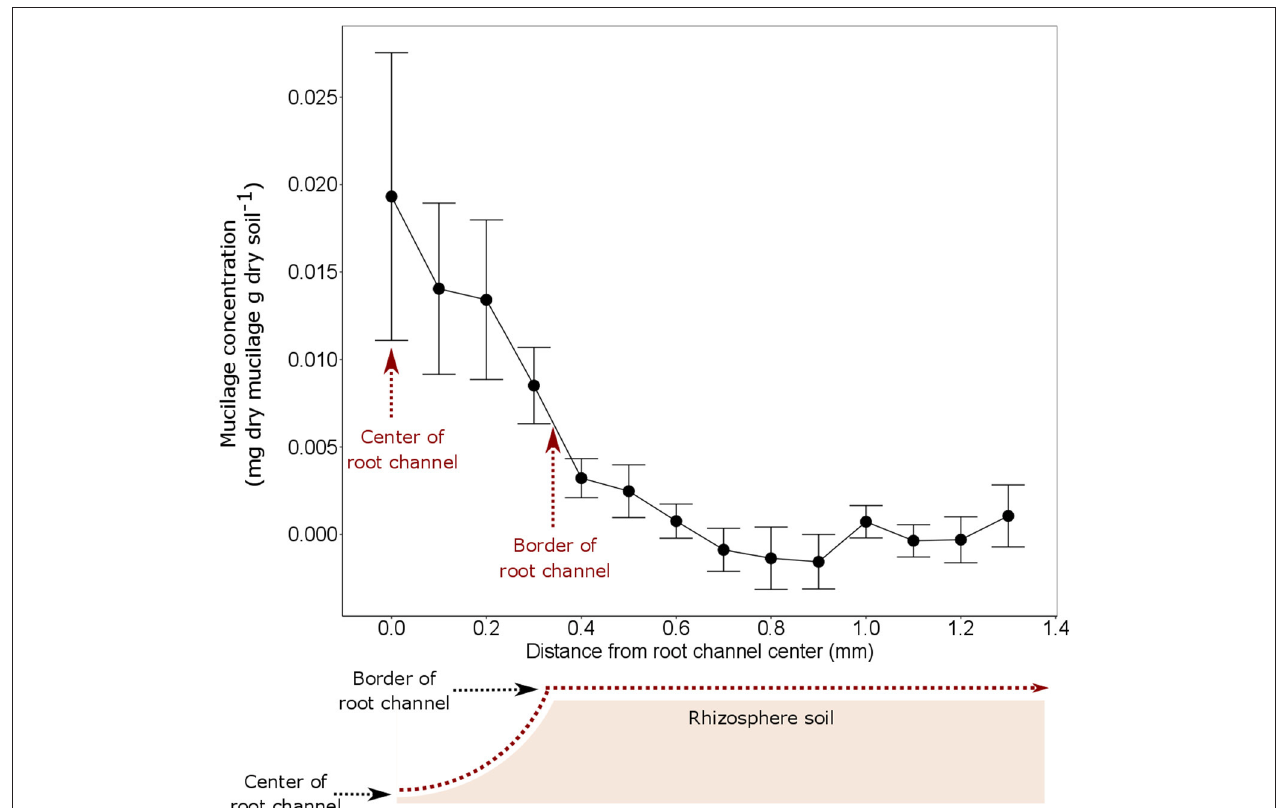
FIGURE 8 | Mucilage concentration (mg dry mucilage per g dry soil) starting from the root channel center in radial direction toward the bulk soil. The measurements from the 3 different root positions were averaged because they did not reveal any statistical difference ( Figure 6 ). The displayed values are the means of 5 replicates (i.e., plants). Variation is given as standard error. x = 0 equals to the position of the center of the root channel as indicated in the sketch below the figure. The average extend of the root channel ( r = 0.34mm) is indicated as border of root channel.